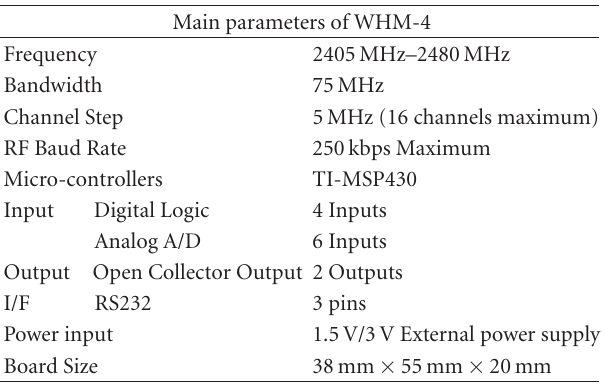
Table 1: Main parameters of